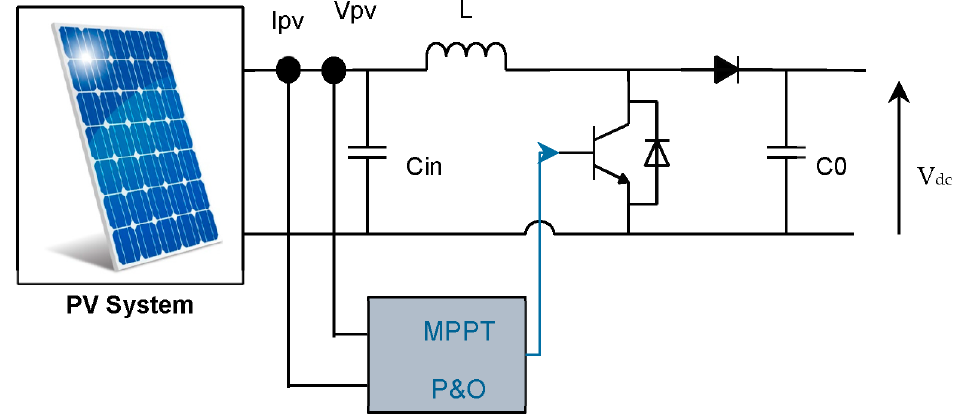
Figure 3. PV system control design.